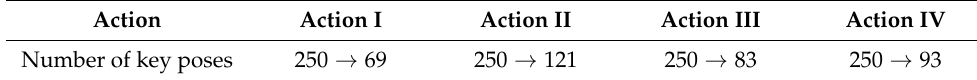
Table 7. Amount of the key poses of Actions I, II, III and